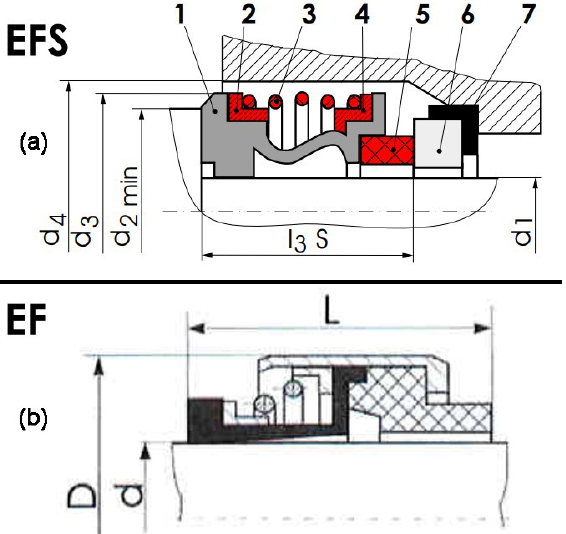
Figure 5. ( a ) EFS-103-S face seal design: 1. Rubber sleeve; 2. Pressure ring; 3. Spring; 4. Pressure ring; 5. Floating ring; 6. Stationary ring; 7. Rubber gasket. ( b ) EF 19 × 45.4 × 3.3 section and dimensions [32].